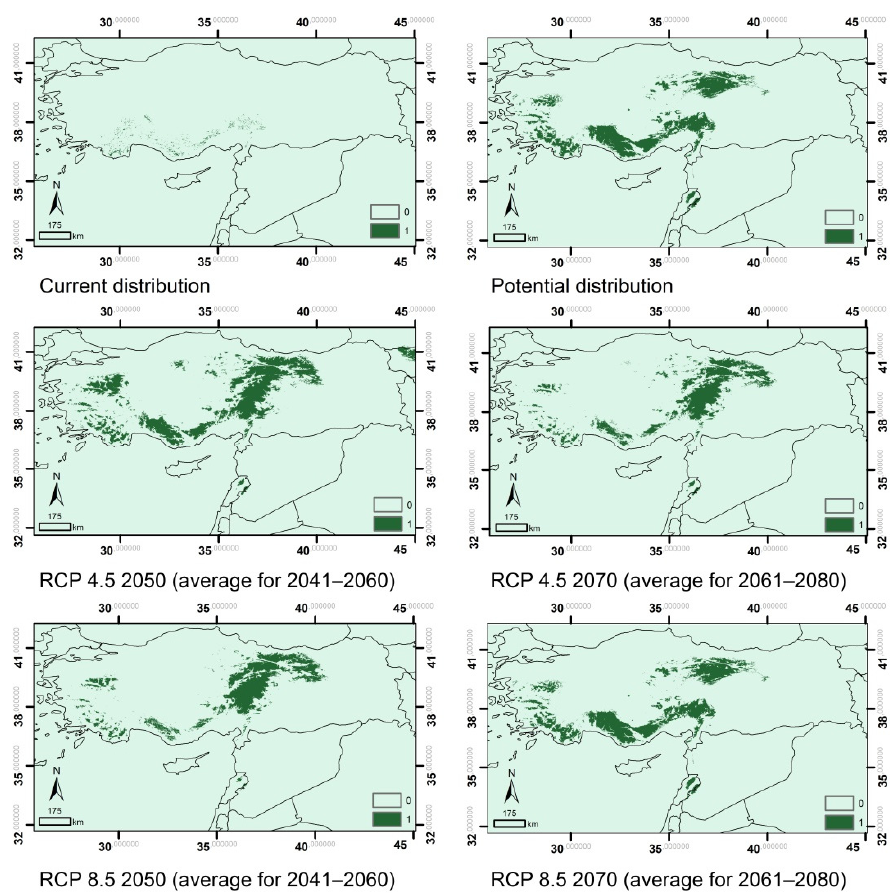
Figure 2. Average prediction of distribution areas under present-time and future climatic projections based on two distinct emissions scenarios (“0” indicates no suitability; “1” indicates suitable areas).